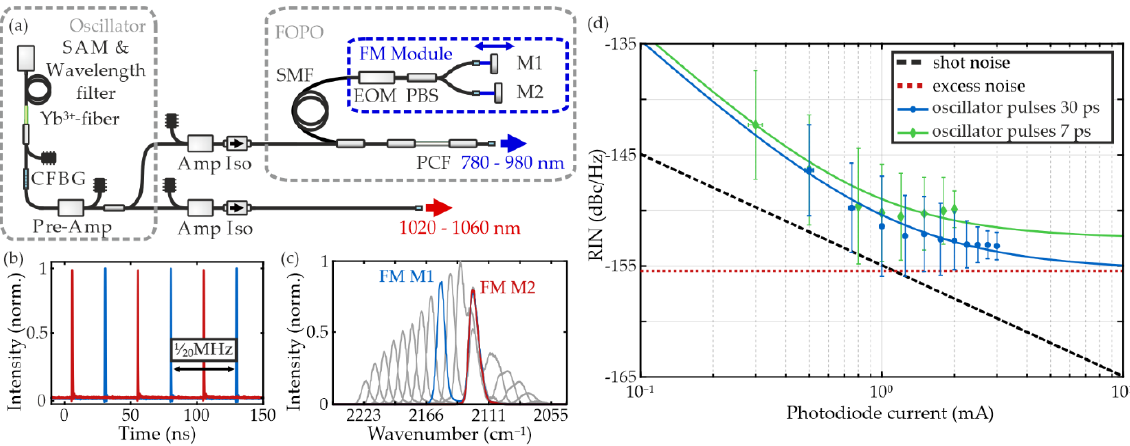
Fig. 1 (a) Schematic of the fiber-based light source with saturable absorber mirror (SAM), chirped fiber Bragg grating (CFBG), amplifiers (Amp), isolators (Iso), single-mode fiber (SMF), photonic crystal fiber (PCF), frequency modulation (FM) unit and mirrors (M). (b) Pulse-to-pulse wavelength-switching by the FM unit at half of the repetition rate of the oscillator. (c) Wavelength tunability within the four-wave mixing gain. (d) Relative intensity noise (RIN) for different pulse durations at variable photodiode